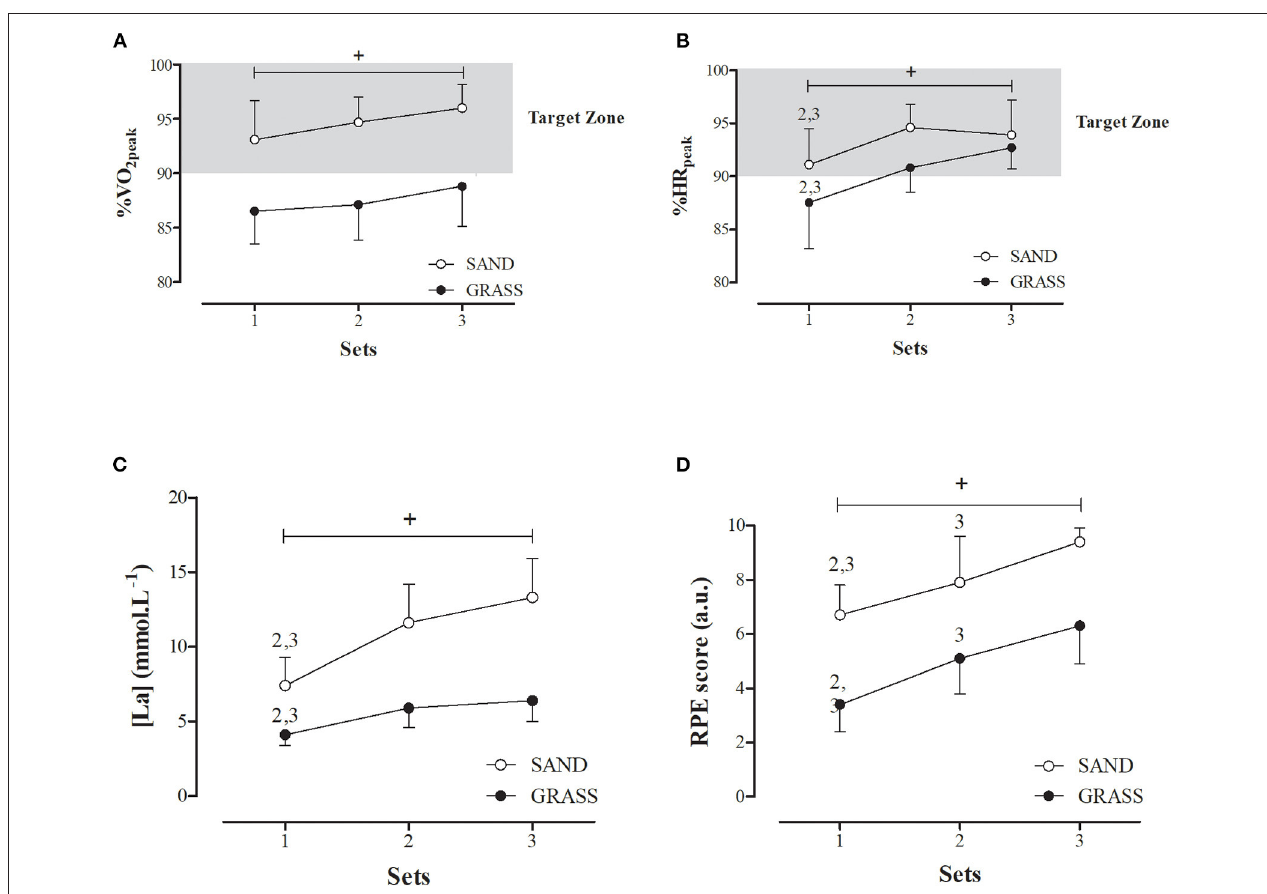
FIGURE 1 | VO 2 (A) , HR (B) , blood lactate [La] (C) , and RPE (D) responses to shuttle-run high-intensity intermittent exercise (HIIE) performed at 100% PS T − CAR on SAND and GRASS surface condition. + : Denotes significant between-condition differences; 2: indicates a significant difference in relation to the second set; 3: indicates a significant difference in relation to the third